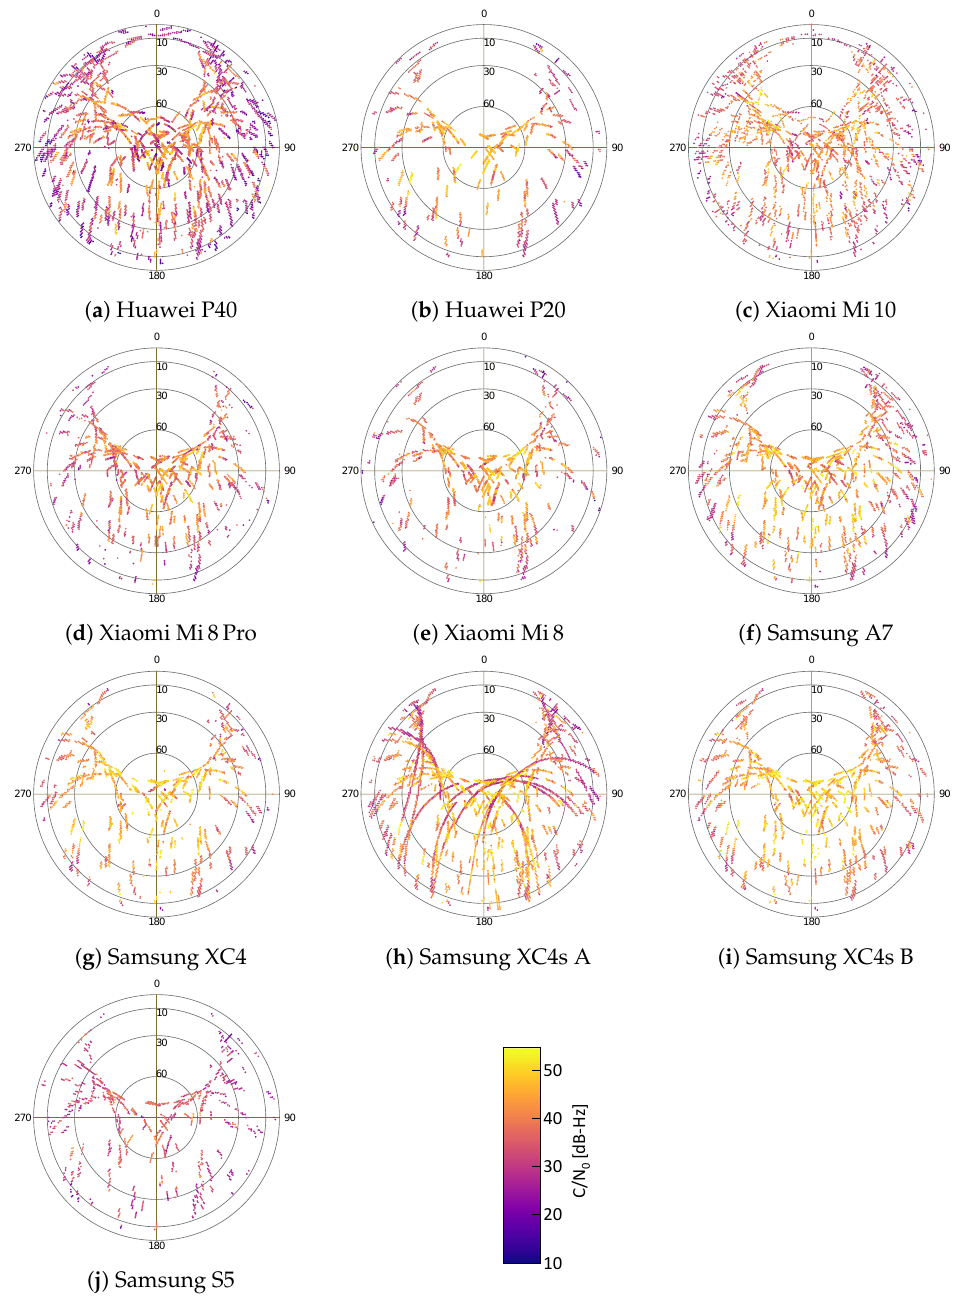
Figure 7. Carrier to noise density ratio C/N 0 skyplots of the GNSS signals collected by the different